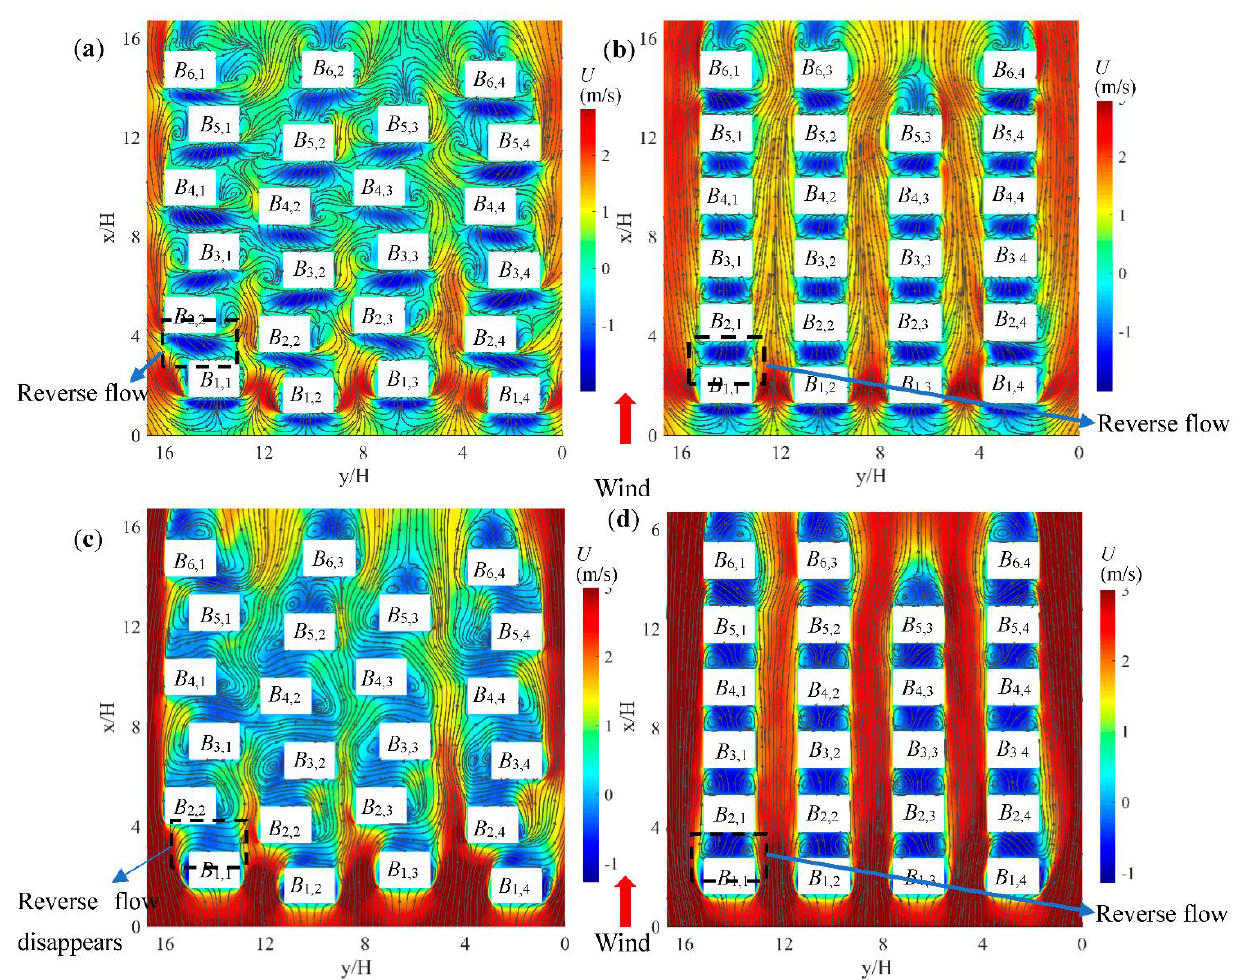
Figure 13. Contours of stream-wise mean velocity U with streamlines at z = 0.06 H for ( a ) DWP ( b ) SWP and at z = 0.5 H for ( c ) DWP ( d ) SWP.